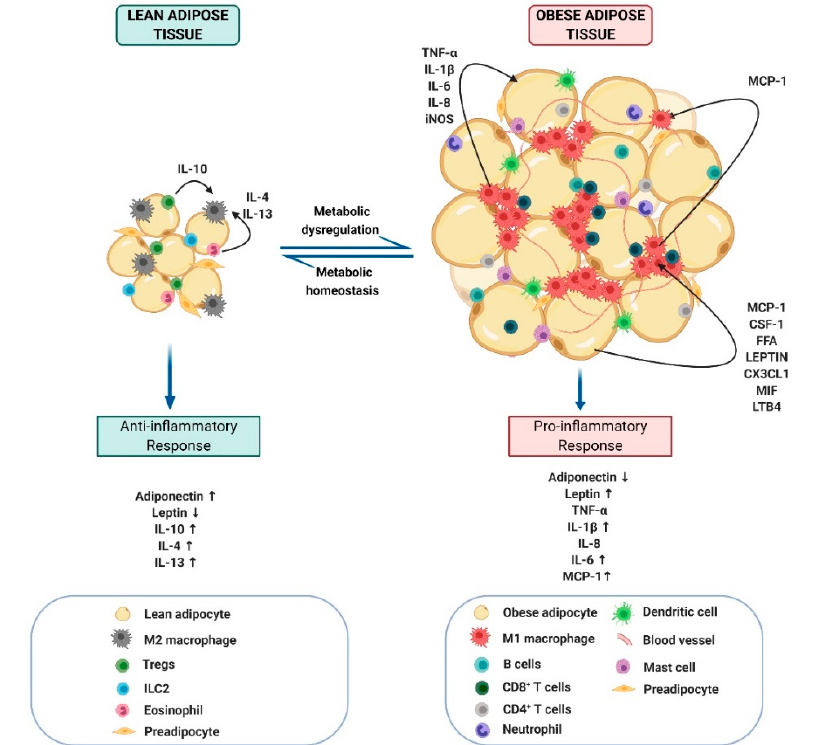
Figure 1. Schematic representation of the cellular dynamics of adipose tissue associated with obesity. As obesity develops, hypertrophic adipocytes and changes in immune cell populations contribute to the development of a chronic inflammatory adipose microenvironment that leads to metabolic dysregulation.